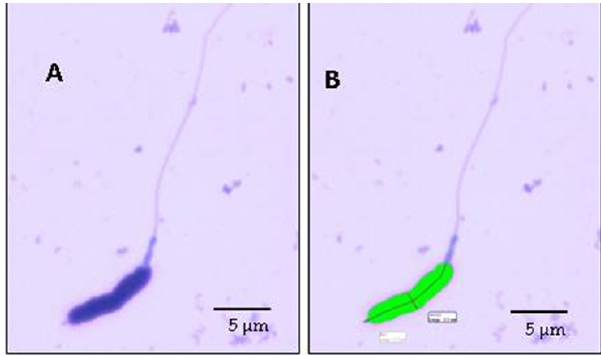
Figure 1 . Flamingo sperm cell stained with Hemacolor ® ( A ) Image of capture of flamingo sperm, ( B ) image of analyzed capture of flamingo sperm with Motic Image Advance V 3.0 software (Motic Spain, S.L.U., Barcelona, Spain)).